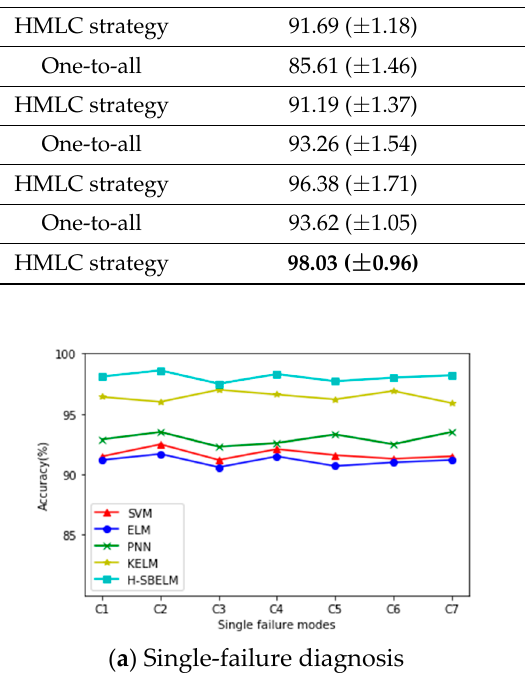
Table 4. The optimal decision threshold and F me.